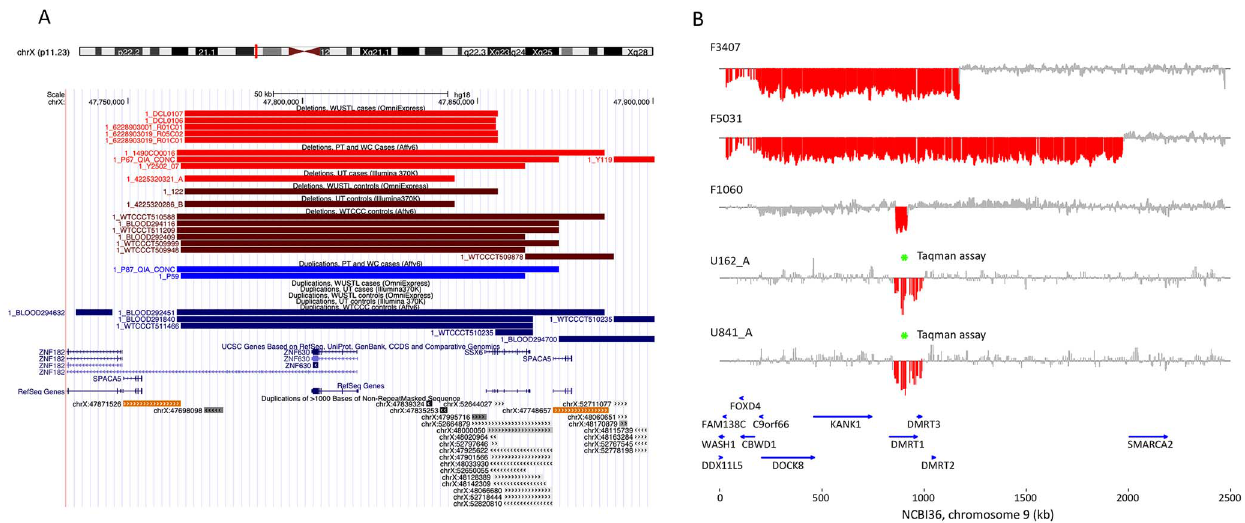
Figure 2. Discovery of recurrent deletions in azoospermia. (A) A recurrent microdeletion on Xp11.23 (47765109–47871527 bp, hg18) is a strong candidate risk factor for spermatogenic failure. The location of deletions (red shades) and duplications (blue shades) in cases and controls are plotted separately for each cohort. CNVs at this locus appear to arise due to non-allelic homologous recombination between two nearly identical ( . 99.5% homology) 16 kb segmental duplications that contain the sperm acrosome gene SPACA5 . Also within the CNV region are the genes ZNF630 and the cancer-testis antigen SSX6 . We identified 9 deletions of this locus spread across all patient cohorts (3 in PT, 1 in UT, 5 in WUSTL) compared to 8 in the pooled 1124 controls (2.8% frequency versus 0.7%, odds ratio=3.96, p=0.005, Fisher exact test). After analysis of an additional 403 cases and 2121 controls, the association is still significant (combined data: 1.6% frequency in cases, 0.55% in controls, OR 3.0, 95% CI=[1.31–6.62], p=0.007). (B) We identified two patients with deletion of DMRT1 , a gene on 9p24.3 that is orthologous to the putative sex determination locus of the avian ZW chromosome system [36]. Both men were diagnosed as azoospermic. We validated these deletion calls with a qPCR assay (green star, Figure S9). We screened Affymetrix 6.0 data from an independent Han Chinese case-control study of NOA and identified an additional 3 deletions of DMRT1 coding